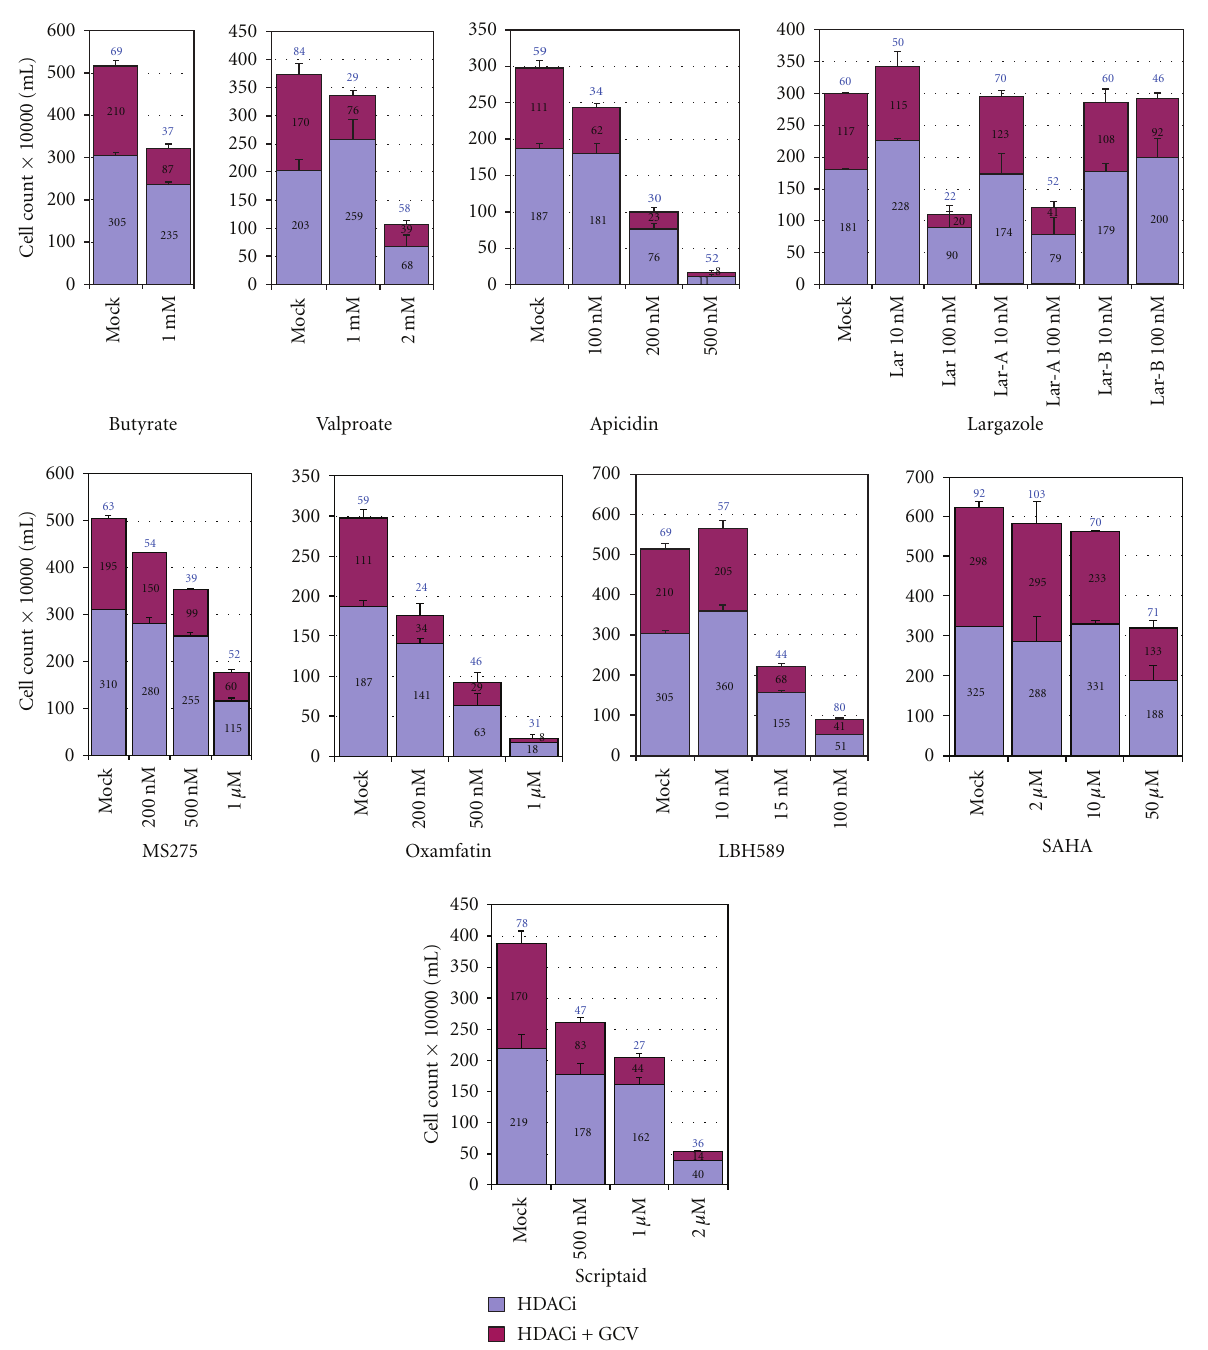
Figure 2: Cytotoxic activity of various HDACi in the presence of an anti-herpesvirus nucleoside analog prodrug, GCV. Three hundred thousand P3HR1 cells were exposed to either 40 μ M GCV or vehicle, and the indicated concentrations of individual HDACi, in a 1 mL volume in 24-well plates, in triplicate. Seventy-two hrs later, 800 μ L of the media was removed without disturbing the settled cells and 1mL of fresh growth media containing GCV (40 μ M) was added and the cells, which were cultured for another 72hrs. HDACi studied included butyrate, valproate, apicidin, largazole and its analogs, MS275, oxamflatin, LBH589, SAHA, and Scriptaid. The number above the HDAC+GCV bar represents the percentage of cells surviving, relative to the cultures exposed to that particular HDAC inhibitor alone (assigned a value of 100%). Error bars represent standard